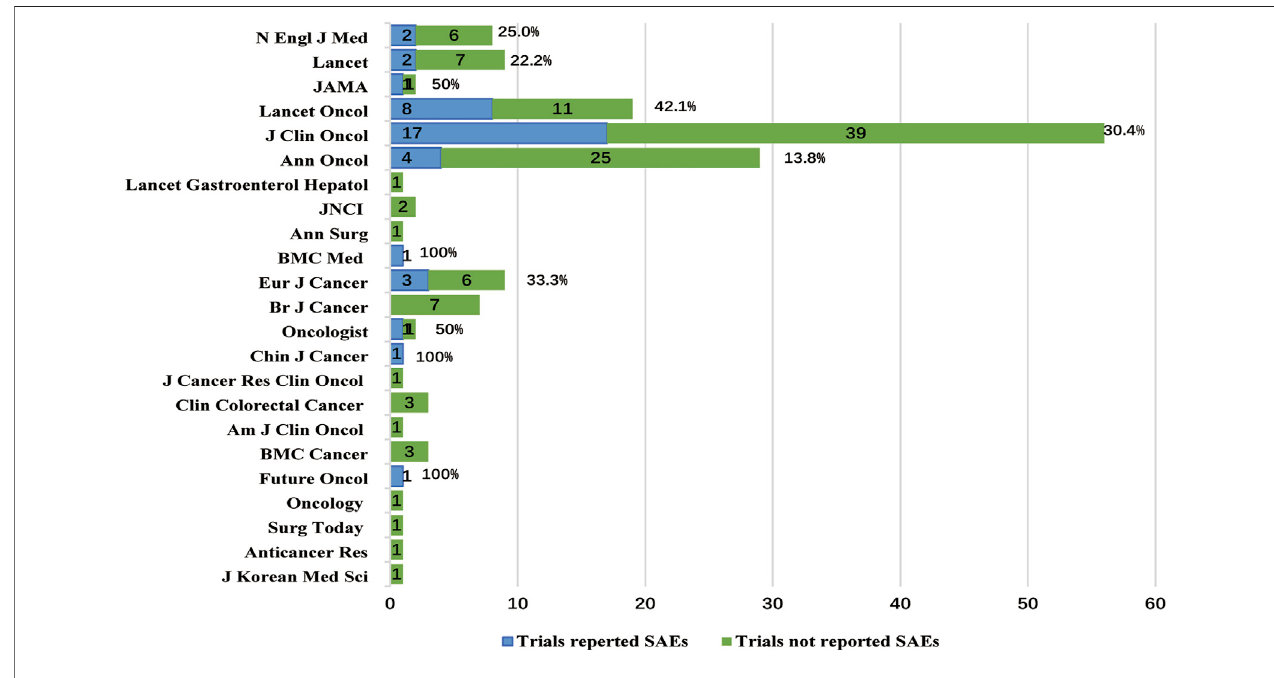
FIGURE 4 | Journals and SAEs reported status.